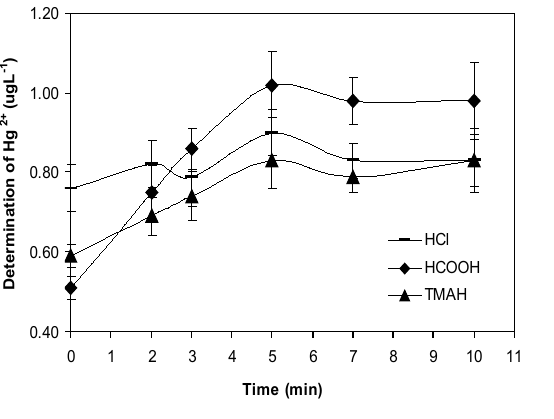
Figure 2. Effect of ultrasonication time on CVAAS response from Figure 3. Effect of ultrasonic power on CVAAS response from 1 µg L -1 1 µg L -1 solutions of Hg 2+ from DOLT-2 (HCl, 5 mol L -1 ; solutions of Hg 2+ from DOLT-2 (HCl, 5 mol L -1 ; HCOOH, ca. HCOOH, ca. 90%; TMAH, ca. 6%; ultrasonic power, 40 W). 90%; TMAH, ca. 6%; ultrasonication time, 5 min).